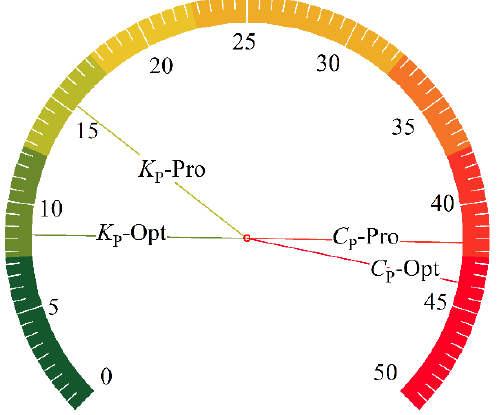
Figure 21. Comparison of the K p and C p before and after optimization.